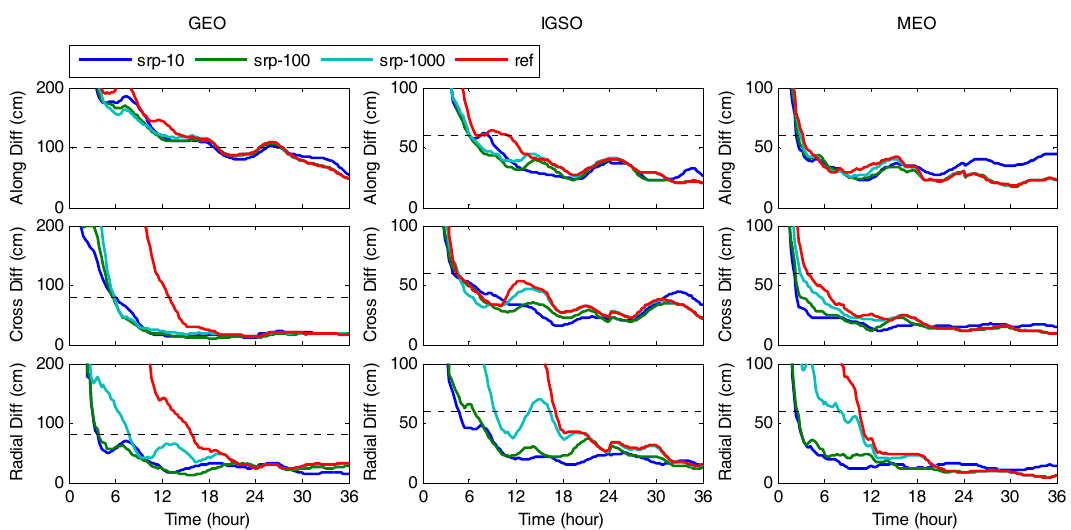
Figure 7. Time series of the average orbit accuracy using different a priori STD of PV parameters. The BRDC product is used as the initial orbit. The horizontal black dotted line represents the convergence criteria for each direction.